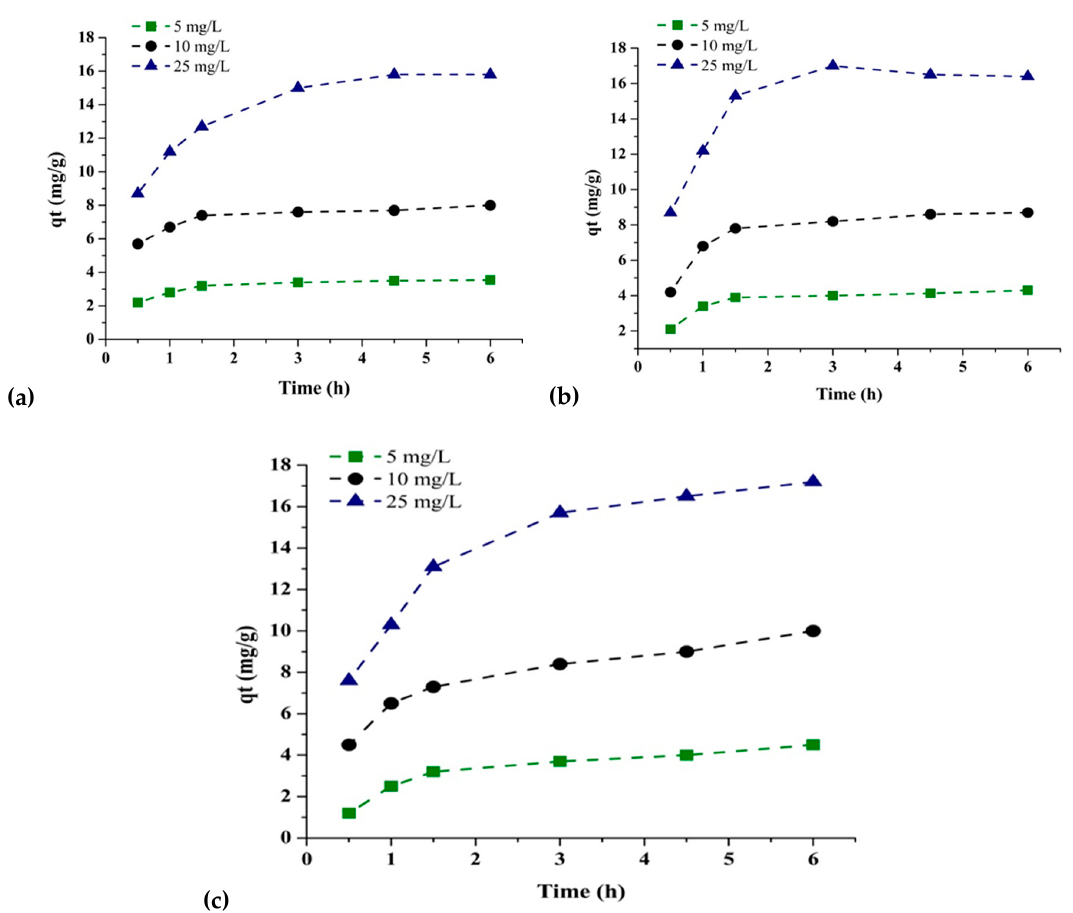
Figure 10. Arsenic removal efficiency at different time intervals and arsenic concentration by ( a ) IONPs ( b ), IONPs–C, and ( c ) IONPs–PA. Table 1. Calculated parameters from pseudo-first model and pseudo-second order model of adsorption kinetics.